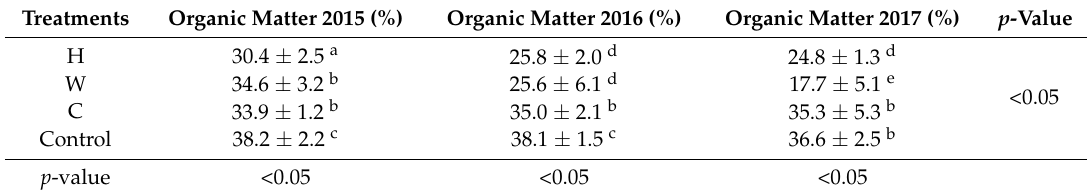
Table 11. Results of the ANOVA and Tukey test for organic matter (df 3, 72; average ± SD), difference tested between the soil of the harvested area, and control.